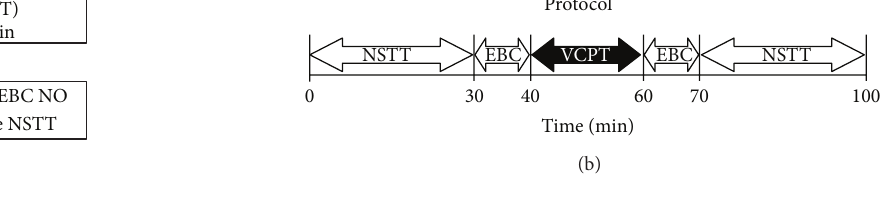
Figure 1: Diagram of the study